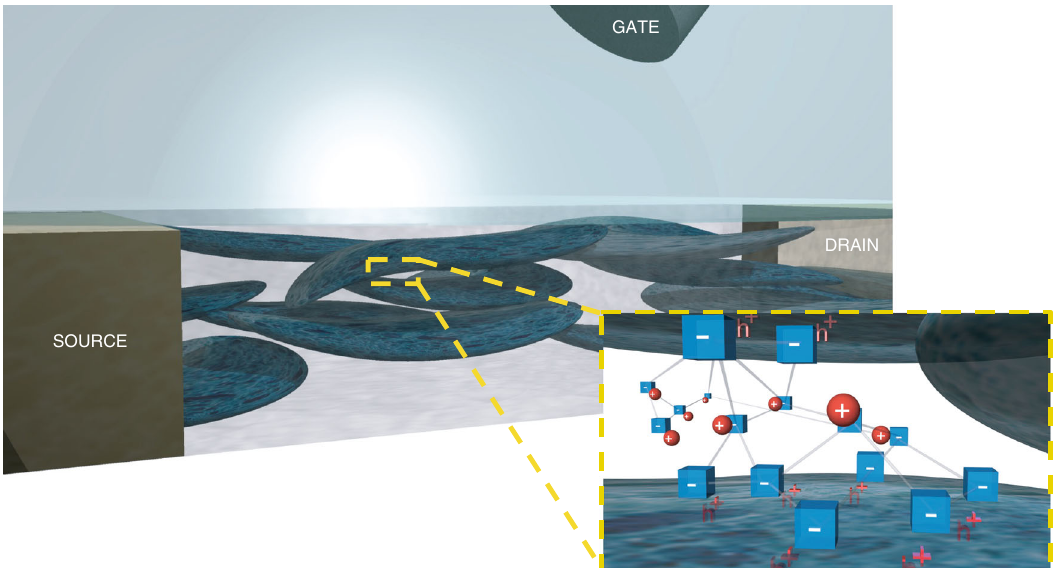
Fig. 4 Schematic material-view of a PEDOT:PSS OECT. The polymeric channel is depicted by PEDOT-rich grains (dark blue) hosted by a PSS-rich matrix (gray). The zoom shows the ionic – electronic interaction in the PEDOT:PSS channel. Fixed anions in the PSS polyelectrolyte (blue cubes) are electrostatically compensated both by holes in the PEDOT semiconductor (red h + ) at the PEDOT/PSS interface and by mobile cations (red spheres) in the bulk of the